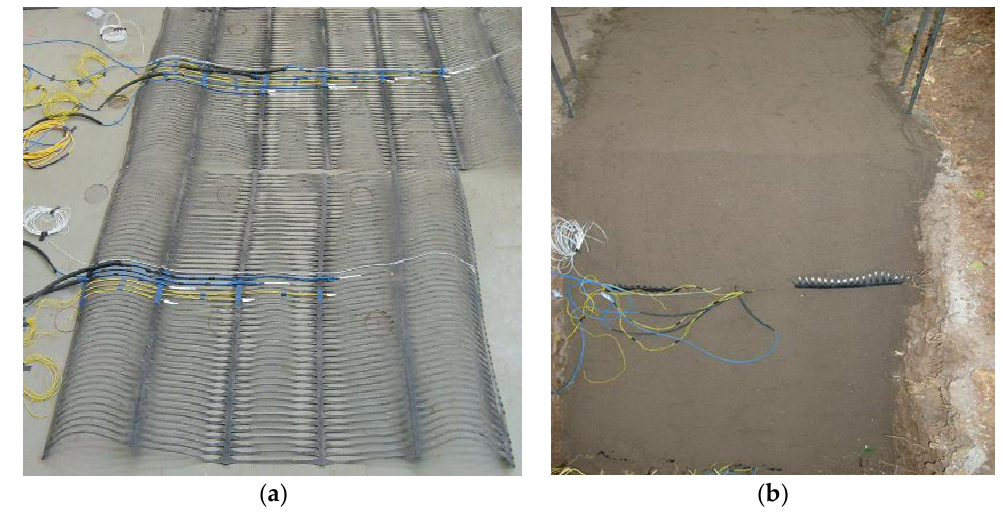
Figure 2. Photographs of the geogrid and s lope model: ( a ) geogrid installed with sensors; ( b ) upward view of the slope.